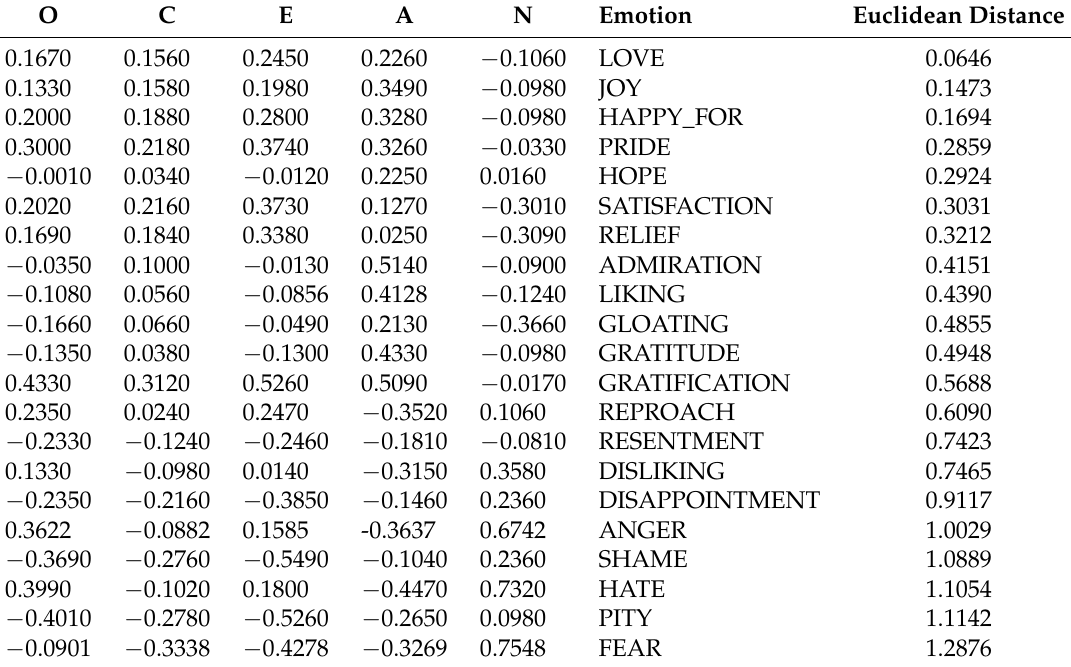
Table 5. The data in Table 1 are presented in ascending order by the Euclidean distance